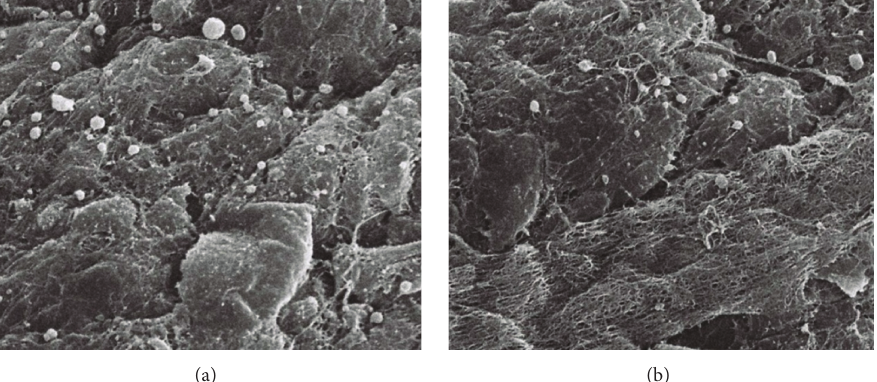
Figure 8: The right eye of Rabbit Number Two, which was exposed to ICG for 60 seconds, had slightly more granules (a) than the left eye (b).